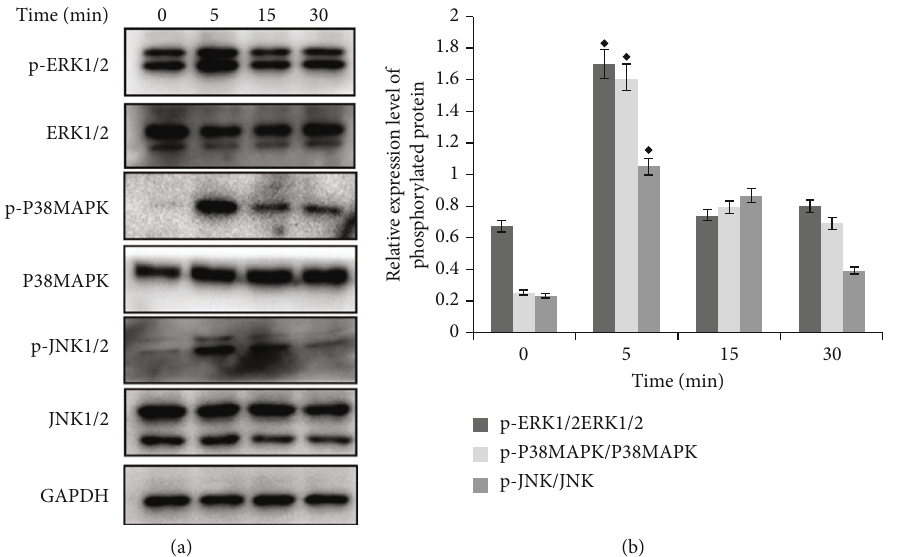
Figure 6: MAPK pathway phosphorylated protein expression for AGE-induced activation of ERK, p38MAPK, and JNK in EPCs. EPCs were stimulated with 100 μ g/ml AGE for 0, 5, 15, or 30min. (a) Phosphorylation levels of ERK, p38, and JNK were analyzed by western blotting. Total MAPK, p38, and JNK expression levels were used as the corresponding controls; GAPDH was used as a loading control. (b) Average phosphorylation levels of ERK, p38, and JNK were determined by presenting the ratio of phosphorylated/total protein expressions. Each data point represents the results of three independent repeats. ◆ P < 0 : 05 vs. 0 min. AGE: advanced glycation end product; EPC: endothelial progenitor cell; p-: